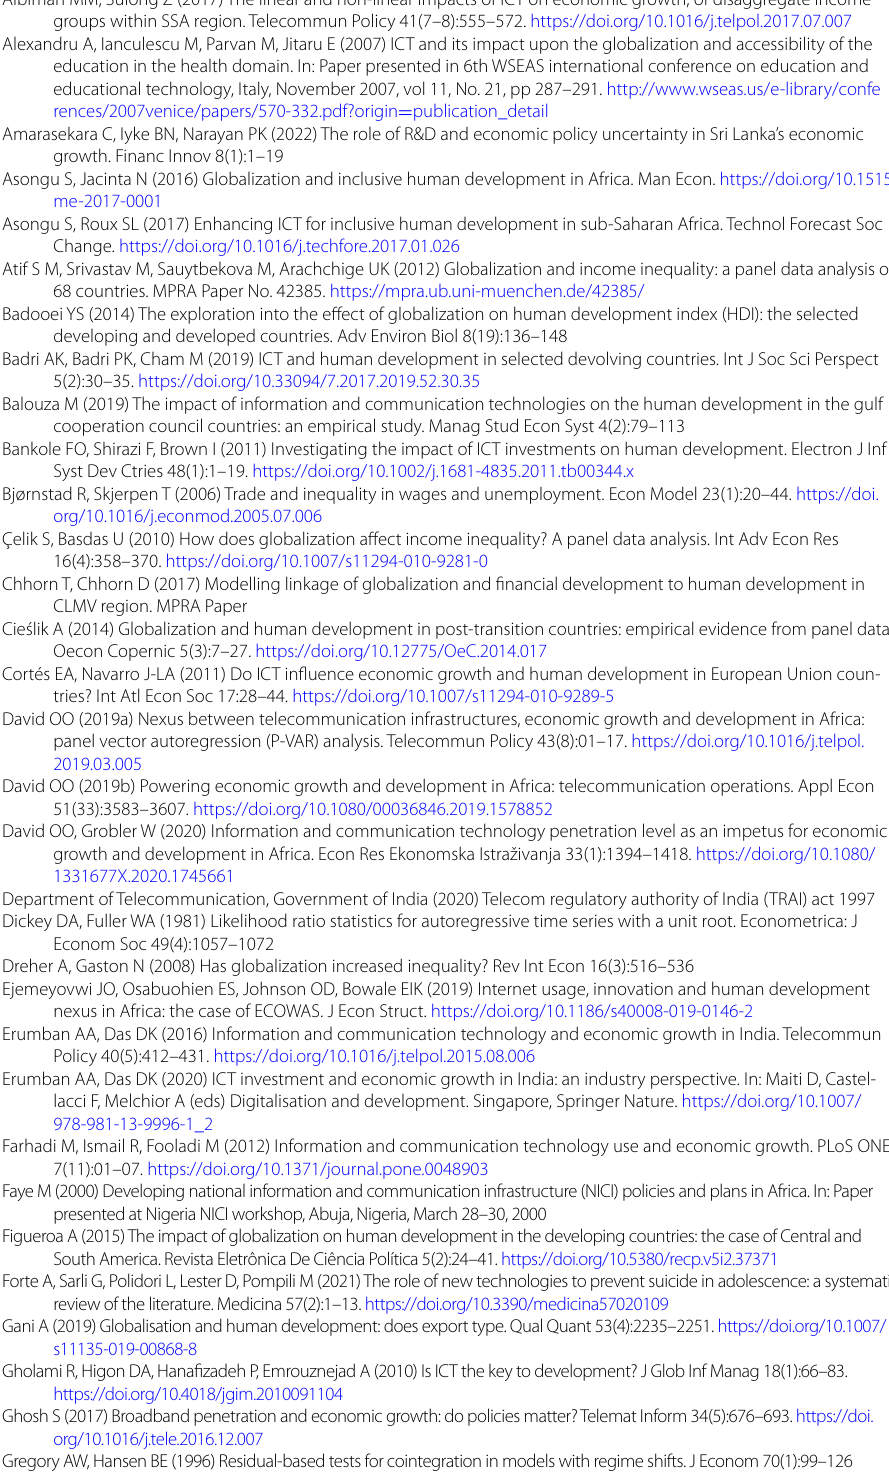
Figueroa A (2015) The impact of globalization on human development in the developing countries: the case of Central and South America. Revista Eletrônica De Ciência Política 5(2):24–41. https:// doi. org/ 10. 5380/ recp. v5i2. 37371 Forte A, Sarli G, Polidori L, Lester D, Pompili M (2021) The role of new technologies to prevent suicide in adolescence: a systematic review of the literature. Medicina 57(2):1–13. https:// doi. org/ 10. 3390/ medic ina57 020109 Gani A (2019) Globalisation and human development: does export type. Qual Quant 53(4):2235–2251. https:// doi. org/ 10. 1007/ s11135- 019- 00868-8 Gholami R, Higon DA, Hanafizadeh P, Emrouznejad A (2010) Is ICT the key to development? J Glob Inf Manag 18(1):66–83. https:// doi. org/ 10. 4018/ jgim. 20100 91104 Ghosh S (2017) Broadband penetration and economic growth: do policies matter? Telemat Inform 34(5):676–693. https:// doi. org/ 10. 1016/j. tele. 2016. 12. 007 Gregory AW, Hansen BE (1996) Residual-based tests for cointegration in models with regime shifts. J Econom